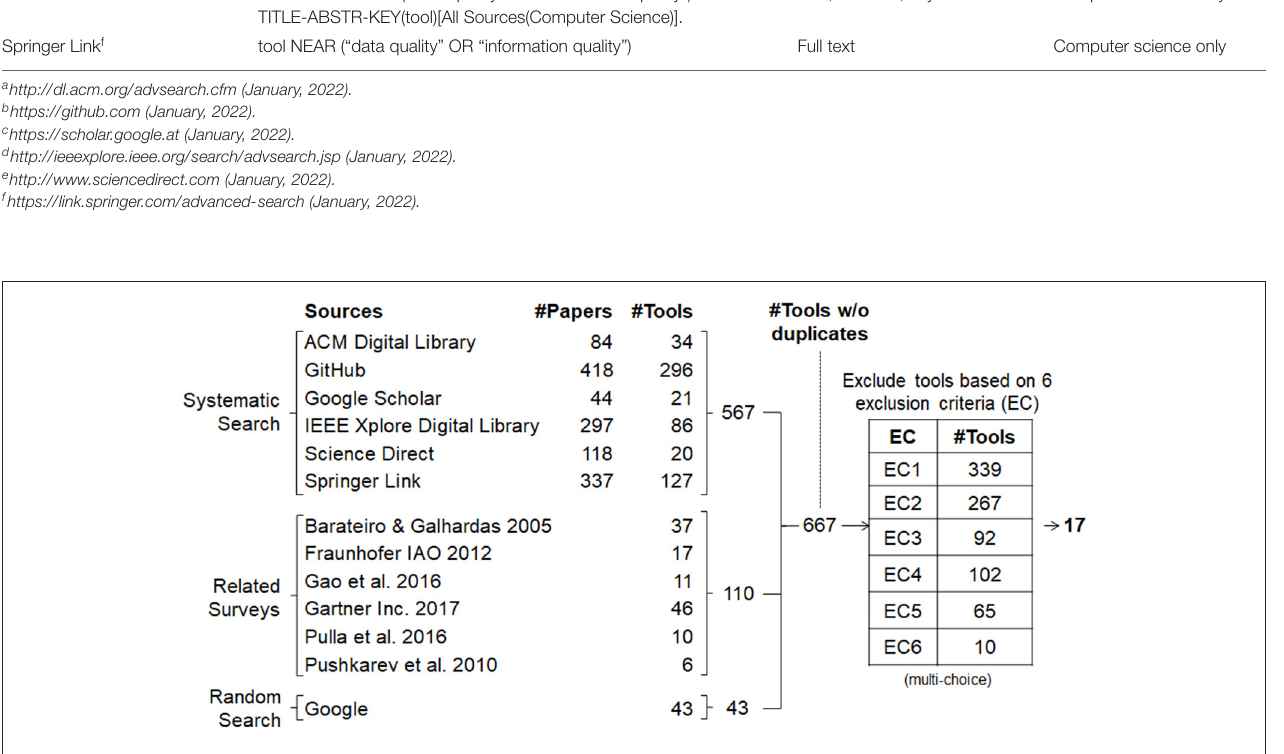
FIGURE 1 | Systematic